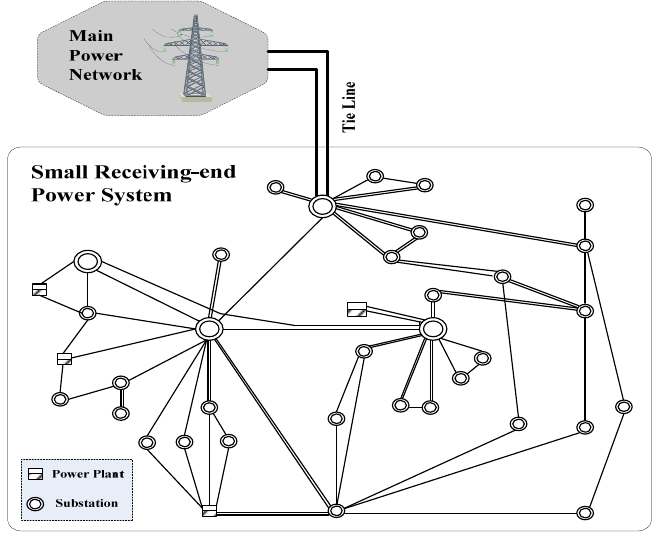
Figure 9. Schematic of the Da Dan power grid.